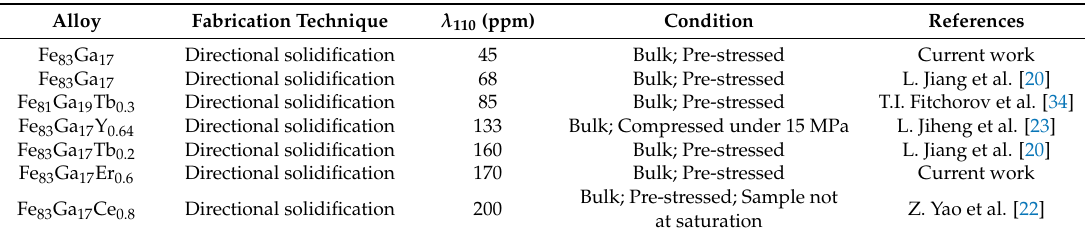
Table 1. Magnetostriction coefficients of [110]-textured rare-earth doped FeGa alloys synthesized via the directional solidification